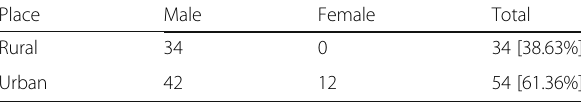
Table 5 Distribution of cases according to source of